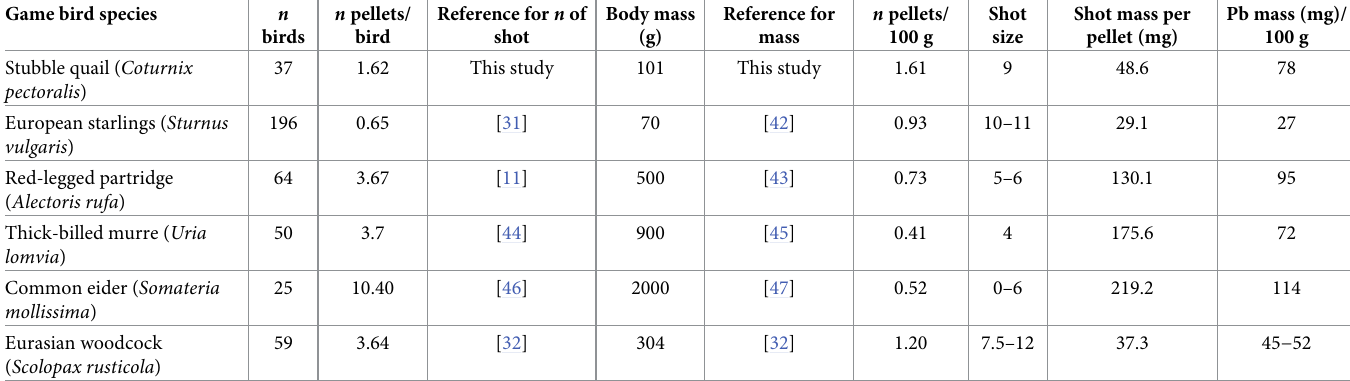
Table 2. Lead contamination in stubble quail ( Coturnix pectoralis ) from south-eastern Australia in comparison to published results from European game bird spe- cies. This table is updated from a past study [31]. Mean body mass and pellet sizes were taken from standard ornithological texts and from hunting sources,